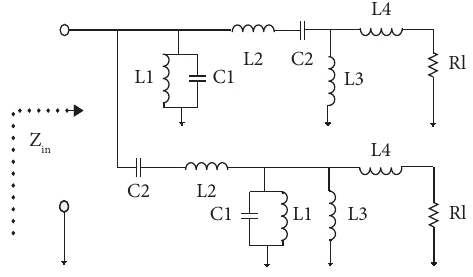
Figure 31: Te circuit of parallel of Figures 27 and